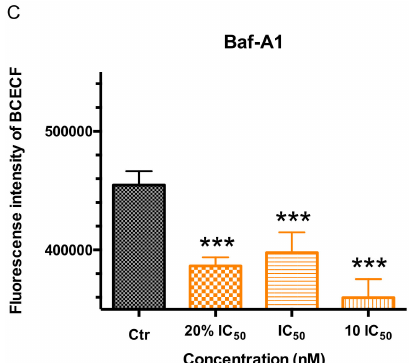
Figure 4. The fluorescence intensity of parasites in trophozoite stage P. f 3D7 staining with pH probe BCECF, AM after 2 h of single drug treatment with a series dose of antimalarial drugs DHA / CQ or V-ATPase inhibitor Baf-A1 by flow cytometry. ( A ) Fluorescence intensity of BCECF in trophozoite stage P. f 3D7 treated by DHA; ( B ) Fluorescence intensity of BCECF in trophozoite stage P. f 3D7 treated by CQ; ( C ) Fluorescence intensity of BCECF in trophozoite stage P. f 3D7 treated by Baf-A1. Ctr means control. Data shown are mean ± SEM (n ≥ 3). * p < 0.05 or *** p < 0.001 vs. control.